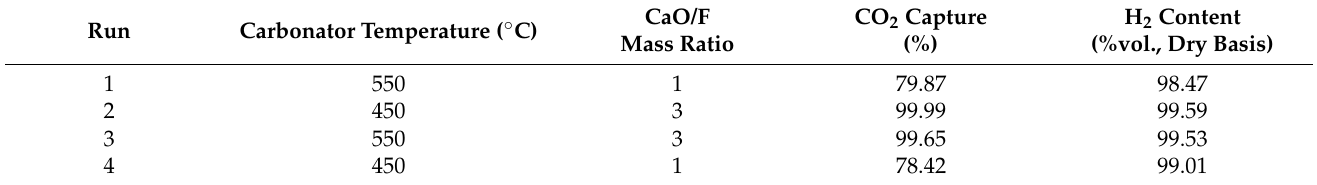
Table 6. The response results from the 2 2 factorial experimental design analysis of the carbon dioxide capture process with Aspen Plus V10.